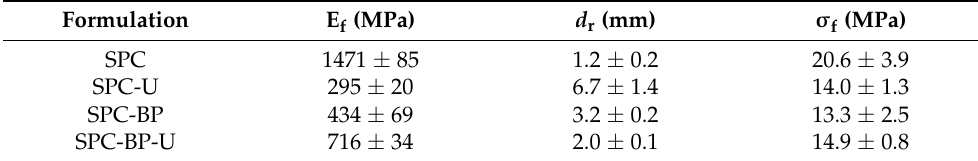
Table 5. Bending properties 1 of the injection-molded pieces.